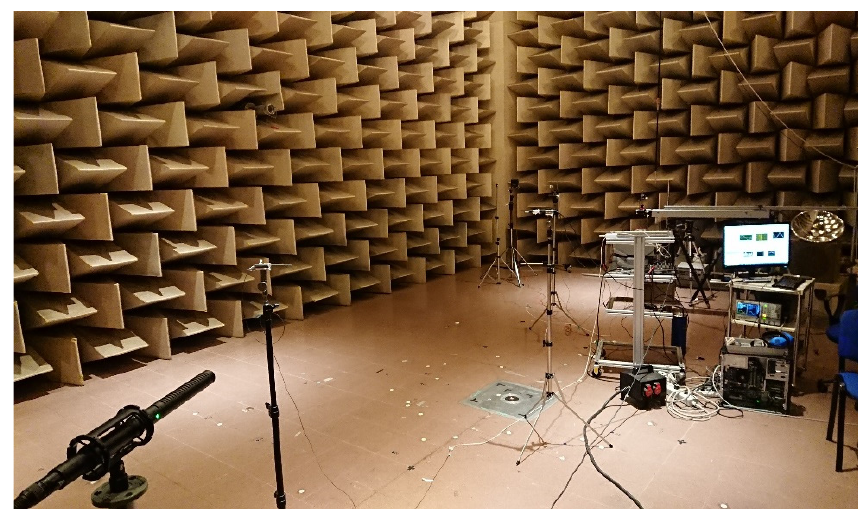
Figure 5. Picture of the setup for the experiment described in this chapter.